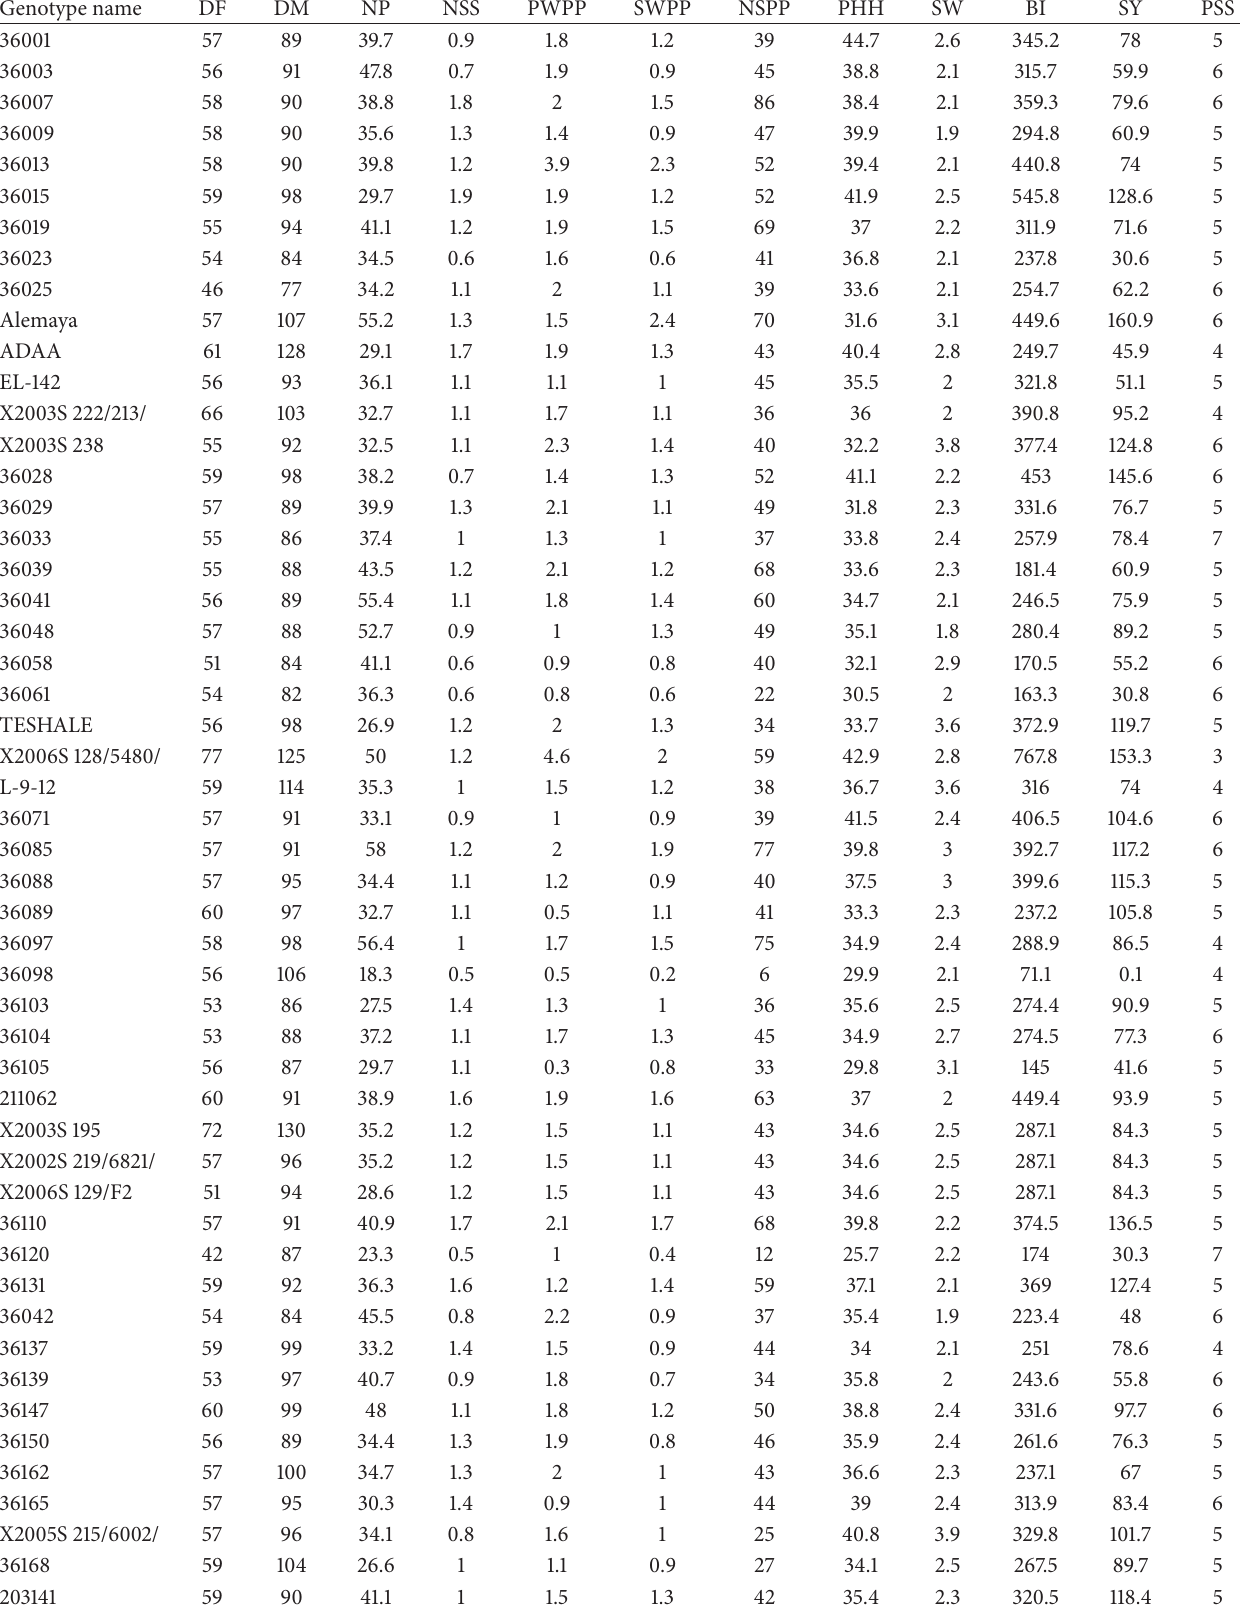
Table 12: Means for yield and yield components of the genotypes at Sirinka